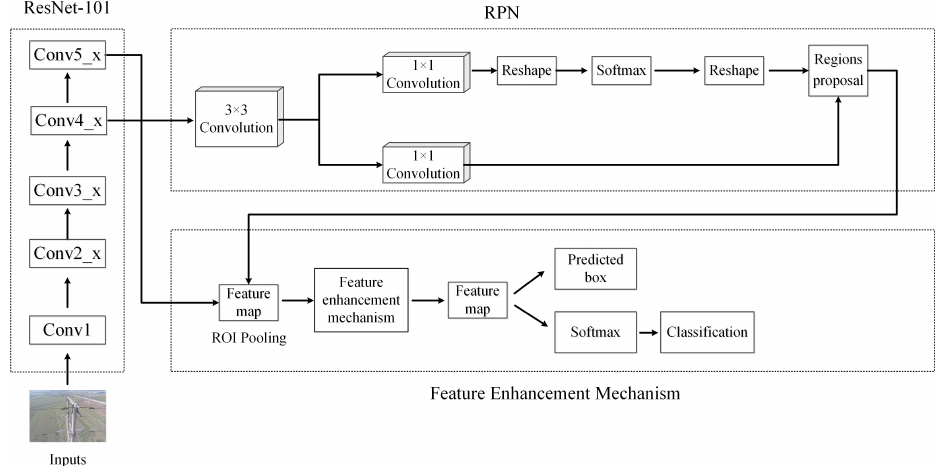
Figure 5. Structure of the proposed new Faster R-CNN model with feature